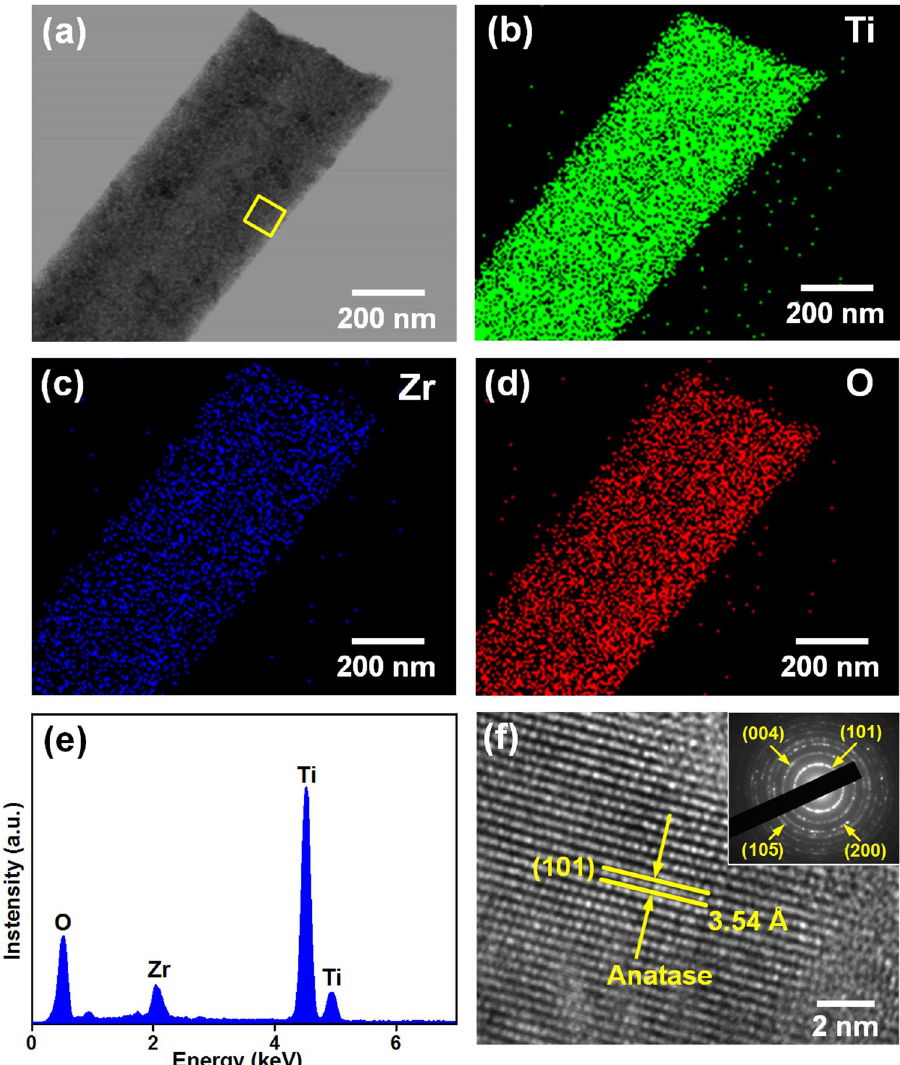
Figure 3. ( a ) TEM image of TZ-10 nanofiber. ( b – d ) Elemental maps of Ti, Zr and O by analyzing the fiber in ( a ). ( e ) EDS spectrum of TZ-10 nanofiber. ( f ) HR-TEM image of the marked area in ( a ). The inset in ( f ) is the corresponding SAED pattern of TZ-10